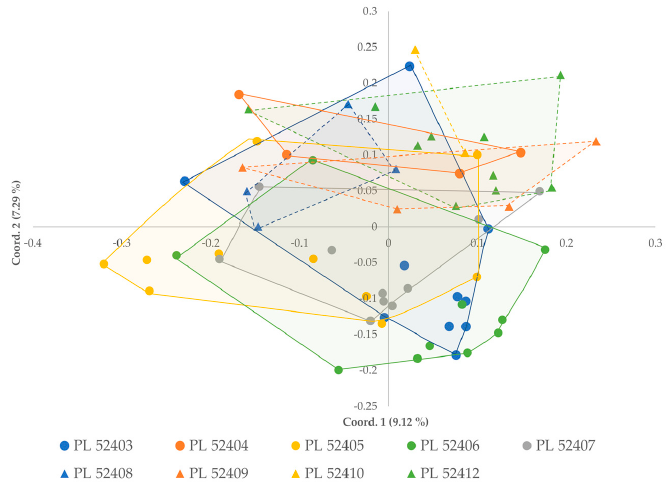
Figure 3. The unbiased genetic diversity coefficient ( uH e ) within nine accessions of Avena macrostachya Bal. ex Cross. et Durieu based on sequence-related amplified polymorphism (SRAP) markers. Homogeneous groups were labeled with the letters. The significance of differences was tested using ANOVA. ( p < 0.05) and post-hoc Tukey’s HSD test.